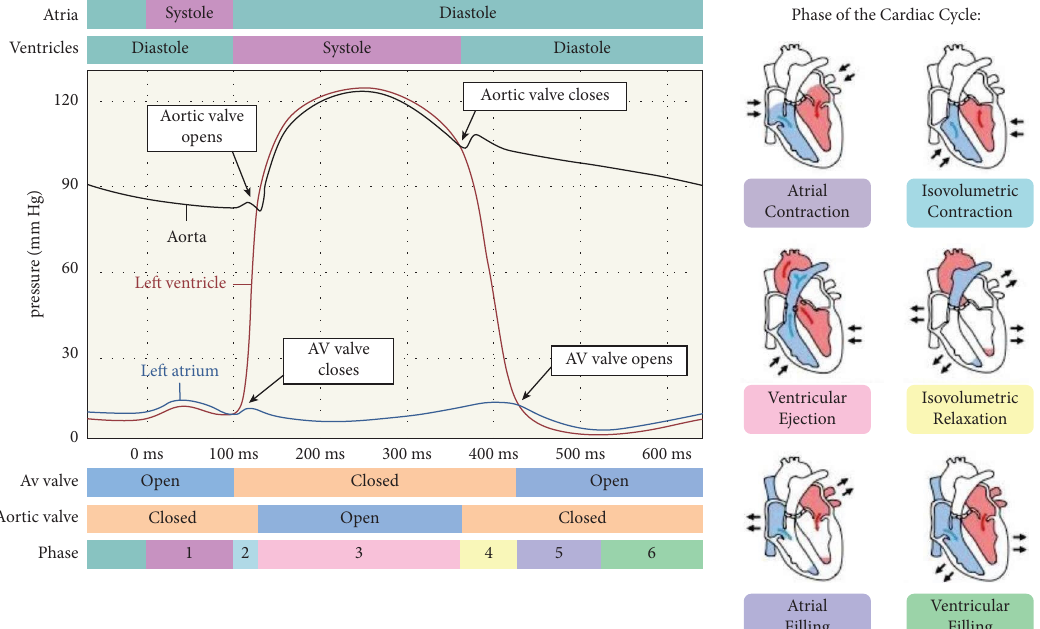
Figure 1: Blood pressure in the aorta compared to that in the ventricles and atria, as well as the rhythm of the heart.